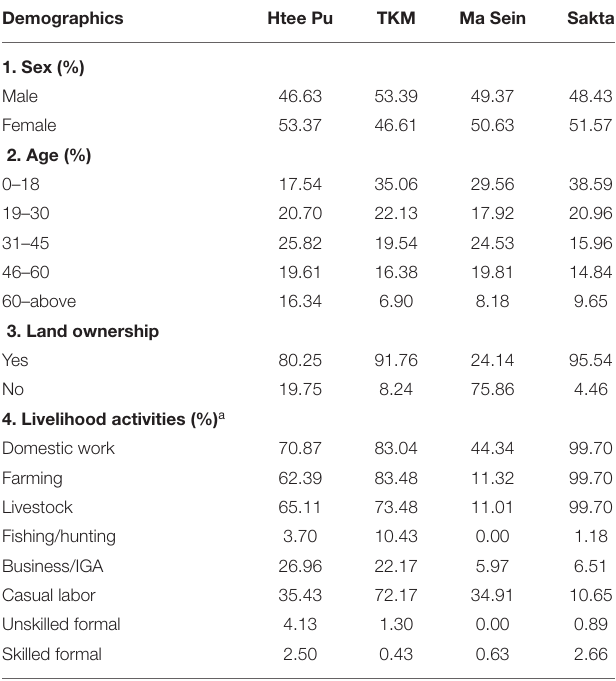
TABLE 3 | Sex and age distribution in the Myanmar CSVs,